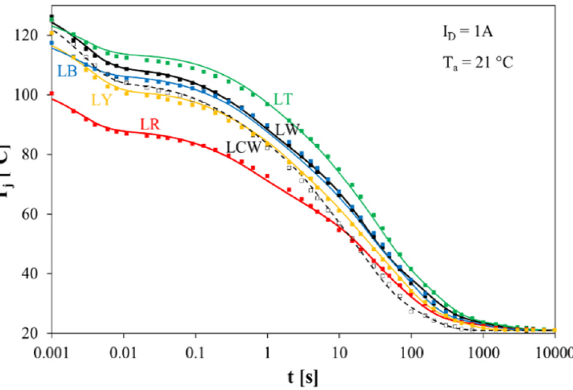
Figure 9. Computed and measured waveforms of junction temperatures of the considered power LEDs while cooling.